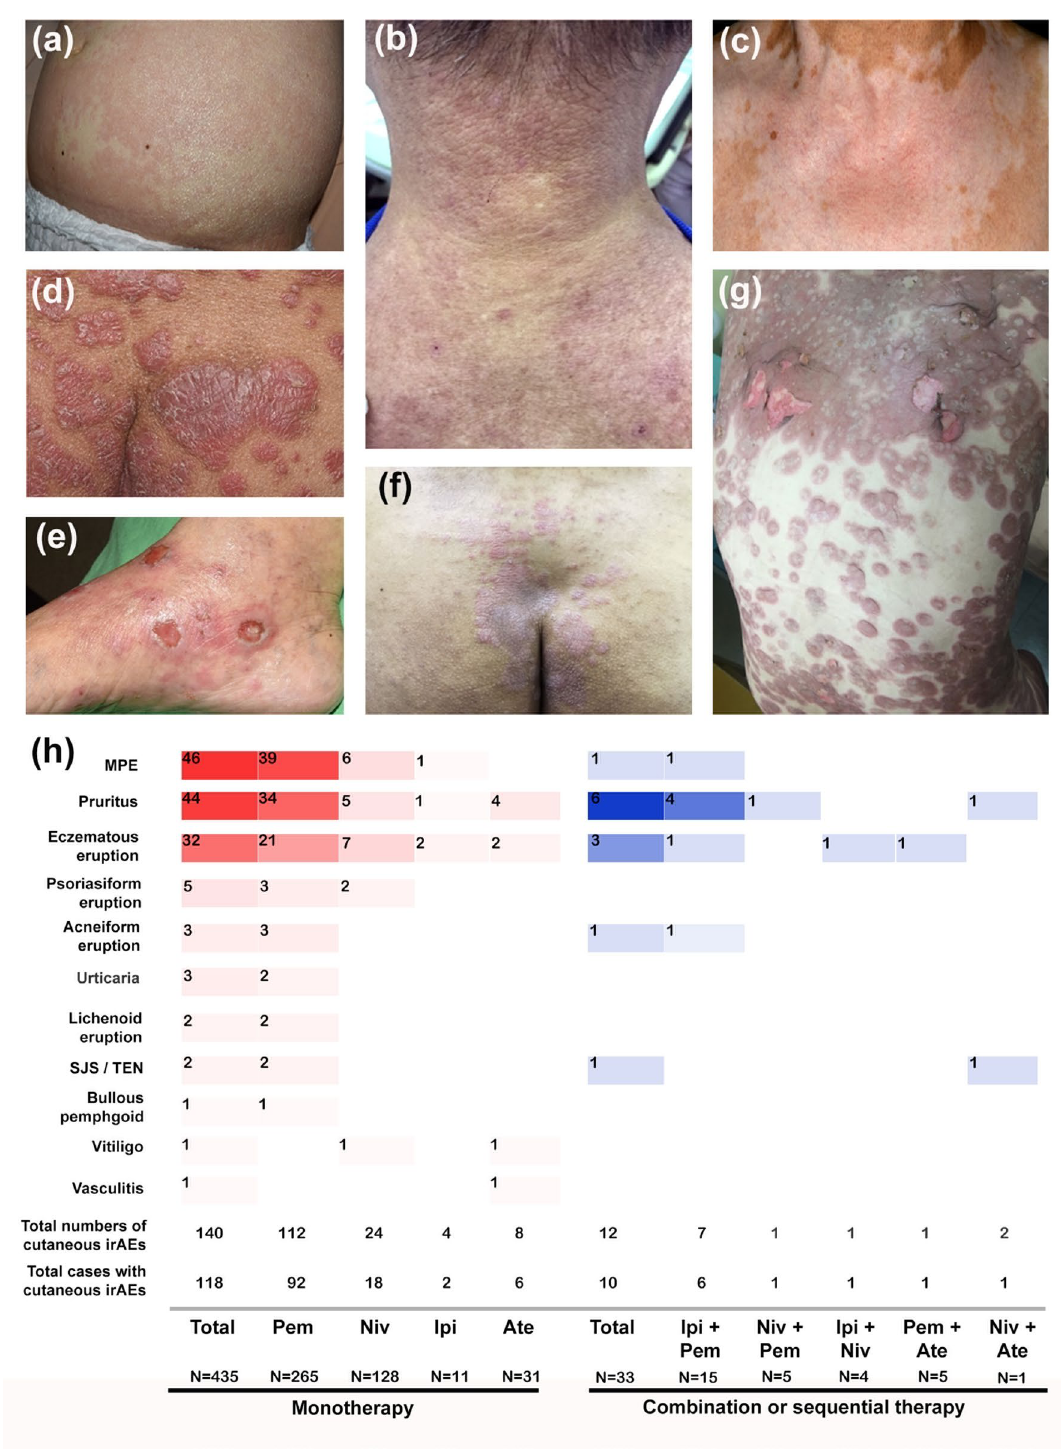
Figure 2. The subtypes of cutaneous irAEs in patients receiving ICIs. ( a ) MPE, ( b ) eczematous eruption, ( c ) vitiligo, ( d ) psoriasiform eruption, ( e ) bullous pemphigoid, ( f ) lichenoid eruption, ( g ) SJS/TEN and ( h ) the distribution of the subtypes of cutaneous irAEs in patients receiving monotherapy or combination/sequential